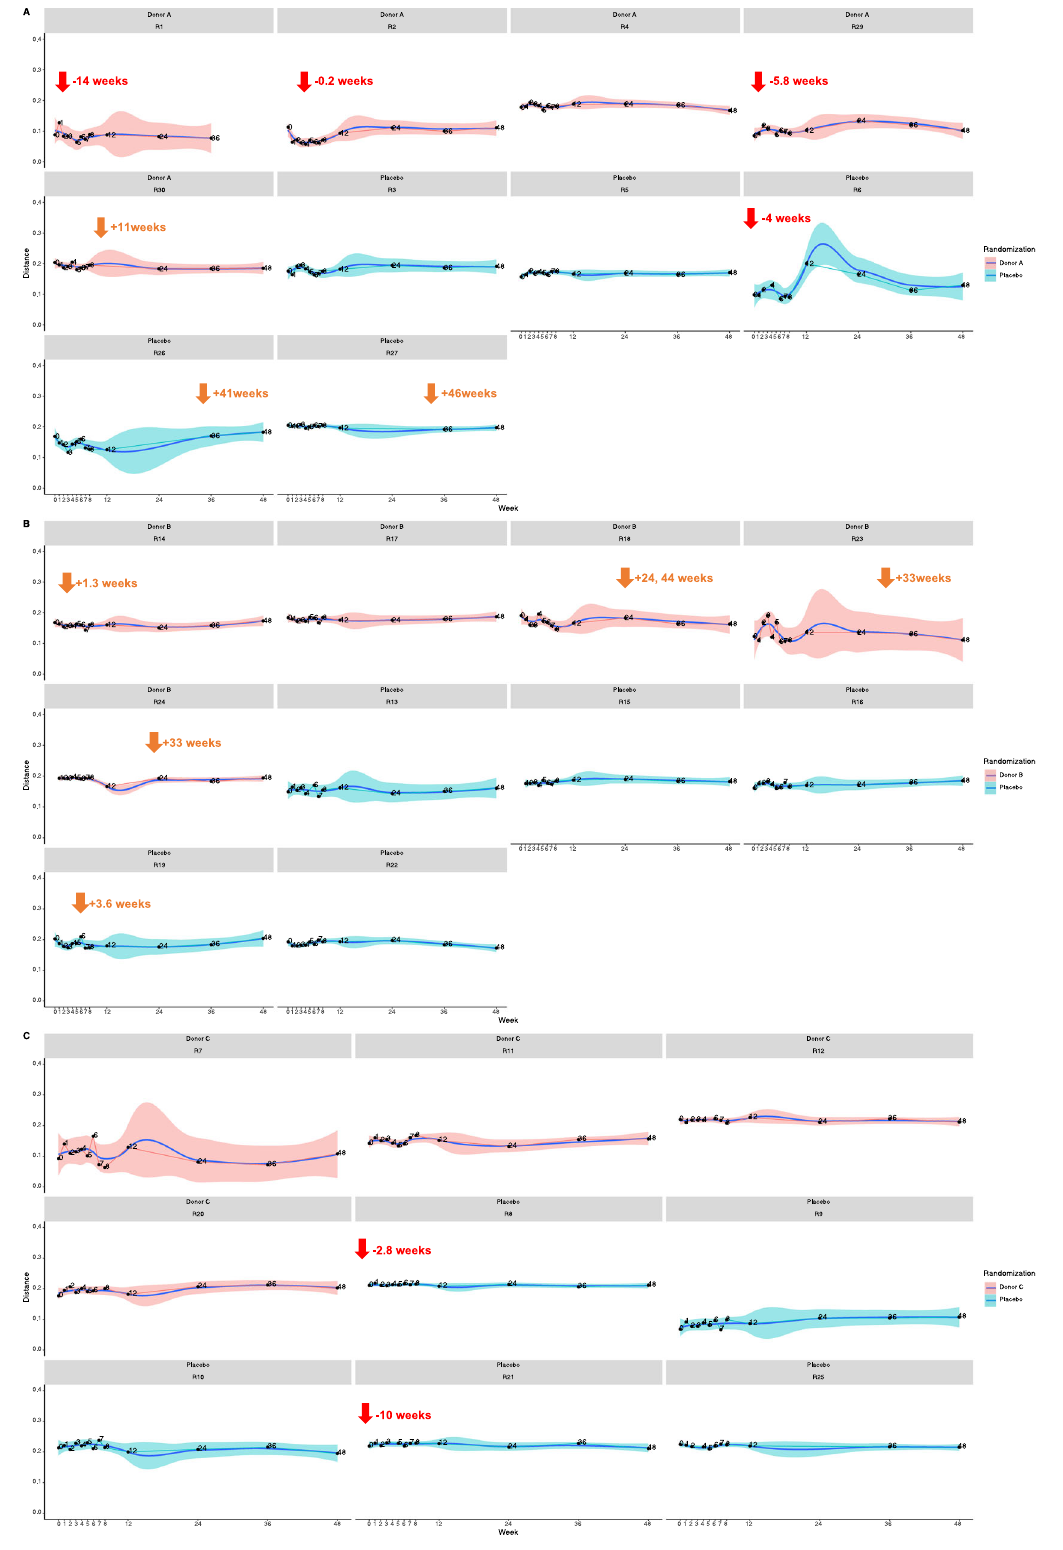
Fig. 3 Engraftment of donor ’ s microbiota on study participants. Individual weighted Unifrac distances from recipients to donor. Individual weighted Unifrac distances from recipients to donors A , B and C (in red) have been represented together in panels A , B , and C , respectively. Black dots represent individual measurements. Blue lines represent the smoothed mean value. Shadow areas represent the 95% con fi dence intervals estimated by the smooth function. Red arrows indicate the use of antibiotics before the baseline, orange arrows indicate the use of antibiotics after the baseline. The Unifrac distances among patients in the placebo arm (in blue) were calculated using the mean values to a donor randomly assigned. Detailed information regarding the type of antibiotic, dosage, duration and indication is provided in Supplementary Table